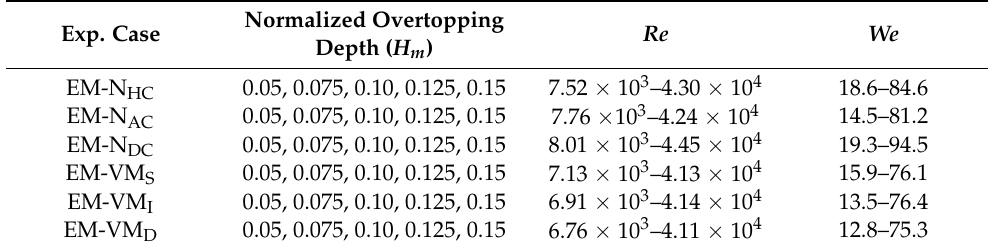
Table 1. Range of the Reynolds number ( Re ) and Weber number ( We ) over the entire experiment. Normalized Exp. Case